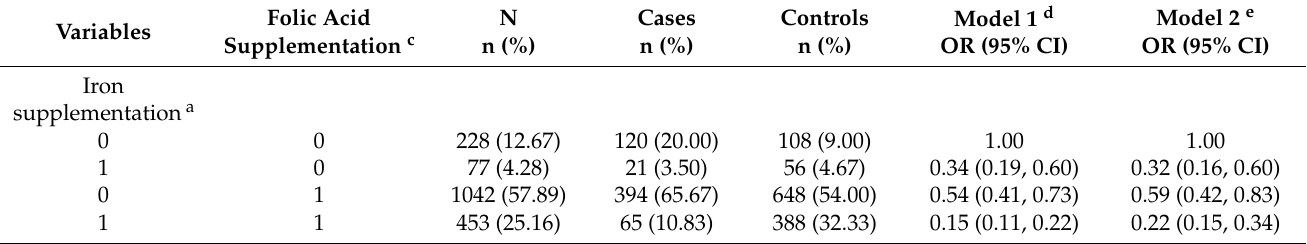
Table 3. Interaction effect of maternal folic acid and iron nutrition on the occurrence of